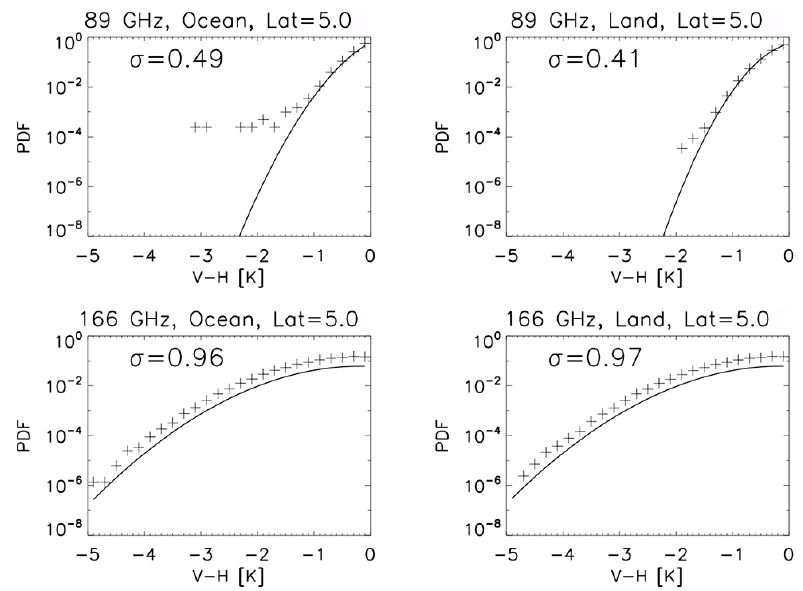
Figure B1. Histogram (cross) of negative PDs based on all GMI observations during January 2015 within the latitude belt of [0, 10 ◦ ]N for 89 (top) and 166GHz (bottom) for ocean (left) and land (right) conditions. The Gaussian distribution fitted curve is plotted in a black solid line, and the standard deviation from the fitted curve is marked in each plot.